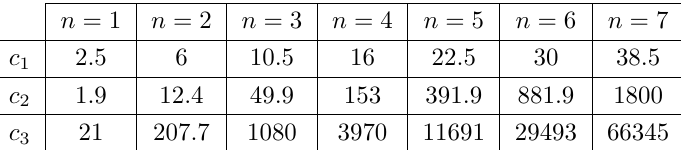
Table 1. Numerical values of coe(cid:14)cients c (cid:12) ( n ) for Ans(cid:127)atz I